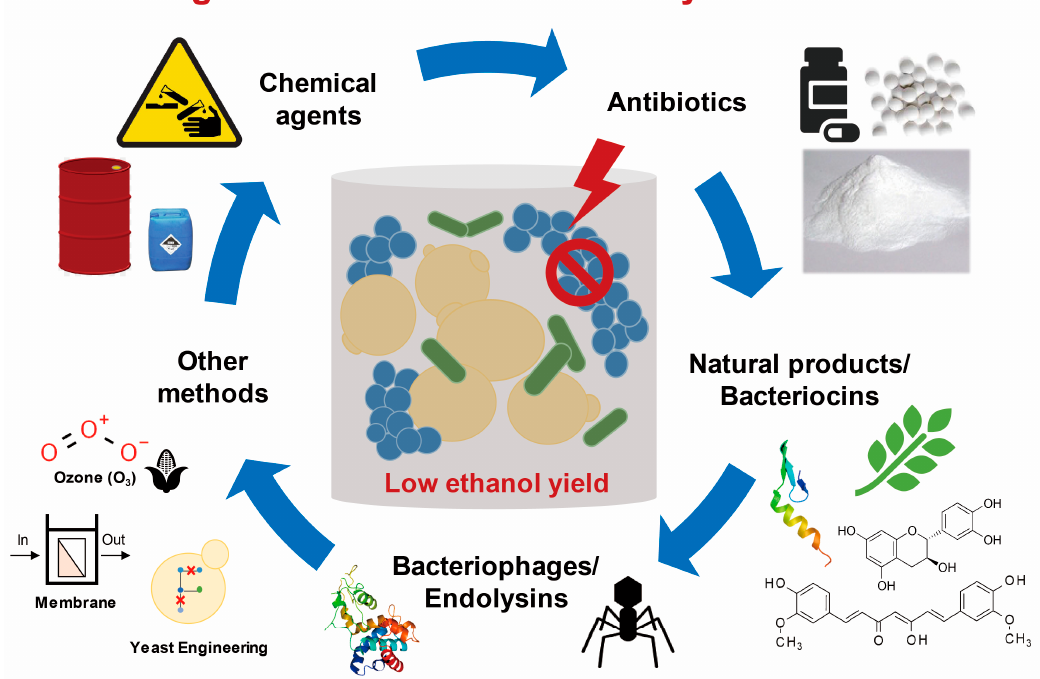
Figure 1. Strategies for controlling microbial contamination in yeast fermentation reviewed in this study. This figure describes the strategies for preventing unwanted bacteria and yeast contamination in alcoholic fermentation by using ( i ) chemical agents such as acids and bases, ( ii ) antibiotics, ( iii ) natural antimicrobial compounds and bacteriocins, ( iv ) bacteriophages and their endolysins, and ( v ) other methods such as disinfection of substrate by ozone treatment, use of membrane bioreactor, and engineering of yeast as a robust host.